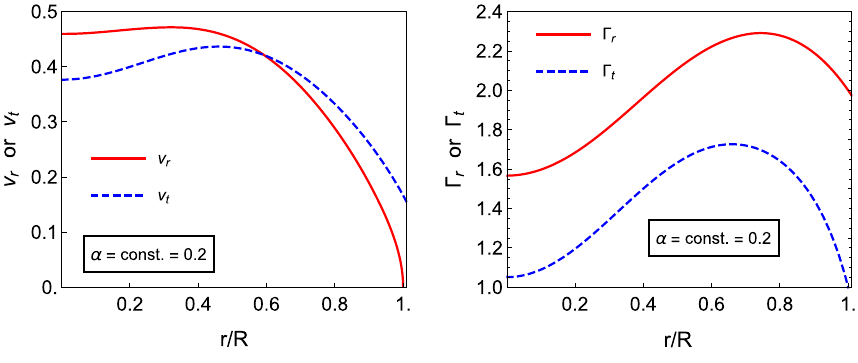
Fig. 3 The dependence of the velocity of sound and adiabatic index with dimensionless radius ( r / R ) for α = 0 . 2 are shown. The pictures are drawn for M 0 = 1 and R =